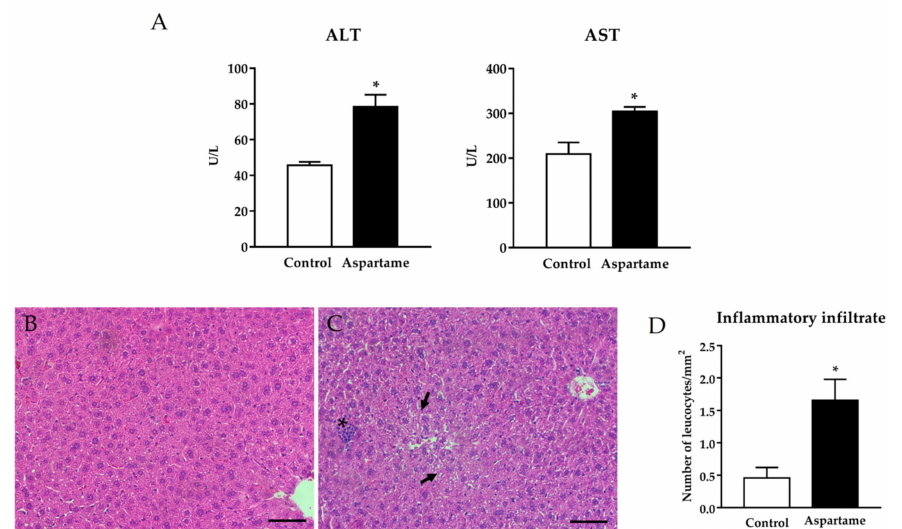
Figure 1. Alanine aminotransferase (ALT) and aspartate aminotransferase (AST) levels ( A ) were measured by spectropho- tometry in the sera of control and aspartame-treated mice ( n = 6, each group). Representative images of hematoxylin–eosin histological staining in the liver of control ( B ) and aspartame-treated mice ( C ). The asterisk indicates inflammatory infil- tration while the arrow reveals a reduction in the nuclear volume and hepatocyte degeneration ( n = 4, each group). Scale bar = 50 µ m. Quantitative analysis of inflammatory infiltrate found in liver sections of mice belonging to the different experimental groups ( n = 4, each group) ( D ). The statistical difference is indicated as follows: * p < 0.05 versus control.